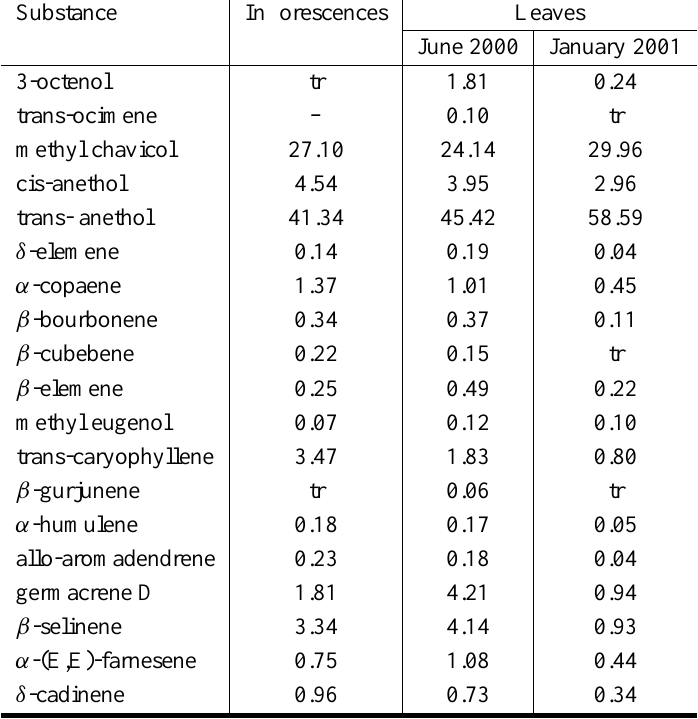
Percentage composition of the essential oils from Ocimum selloi